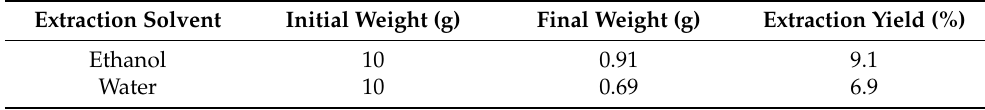
Table 1. Extraction yields of E. camaldulensis crude